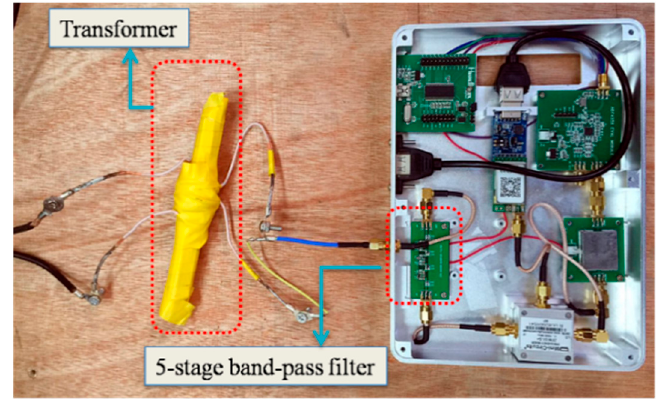
Figure 14. Photograph of the five-stage band-pass filter and transformer.